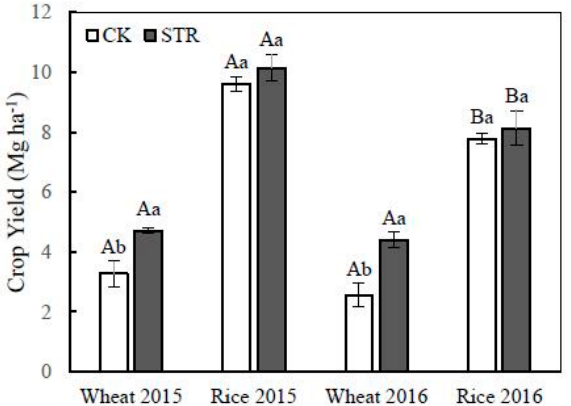
Figure 6. Crop yields were affected by the straw incorporation (STR) and control (CK) treatments. Different uppercase letters above columns for the same treatment and crop indicate a significant difference between harvesting years ( p < 0.05); different lowercase letters above columns for the same crop and year indicate a significant difference between treatments ( p < 0.05).